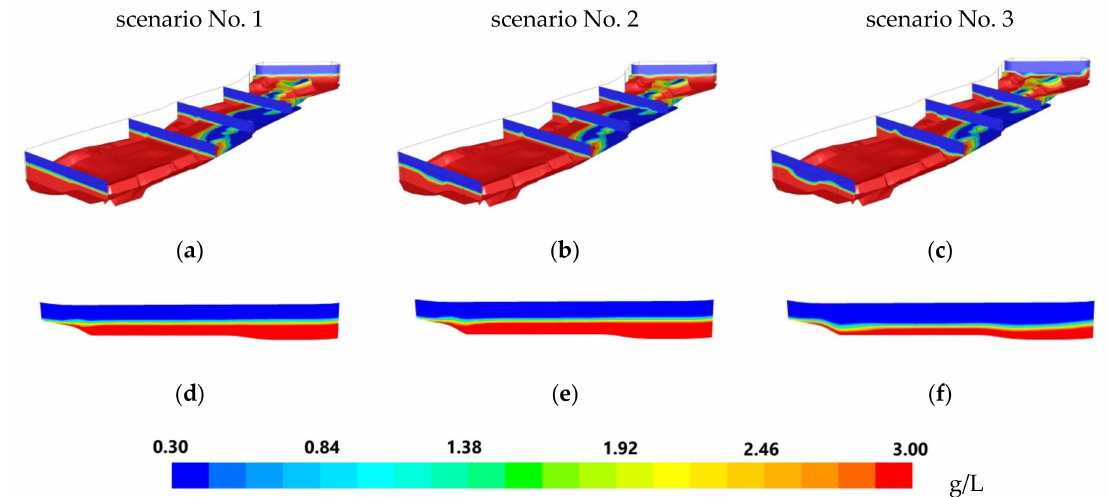
Figure 9. Distribution of mineralization near the BKPRU-4 water intake at the bottom and in vertical sections at a distance of 100 m, 1000 m, 1500 m, 2000 m, and 3000 m from the culvert for water flow through the reservoir at 0.3 m 3 /s ( a ), 2.04 m 3 /s ( b ), and 8.51 m 3 /s ( c ). Mineralization of water in the vertical control section, across the reservoir near the water intake, was 0.3 m 3 /s ( d ), 2.04 m 3 /s ( e ), and 8.51 m 3 /s ( f ).